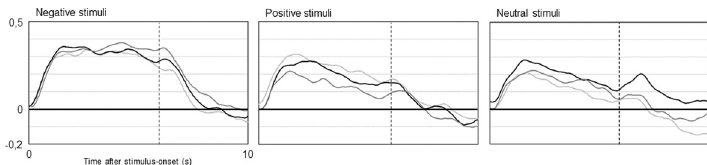
Fig 2. Total averages of pupil size changes during experimental conditions. Total averages (n = 24) of pupillary reactions to auditory stimuli from negative, positive and neutral categories while providing true feedback (light grey) and sham feedback suggesting strong (black) and weak activation (dark grey). Signal courses depict differences from baseline mean (set to zero on the y-axis). Vertical dotted lines indicate end of stimulation (after six seconds). For purposes of presentation, curve progressions are smoothed using a sliding average of half a second (30 data points).